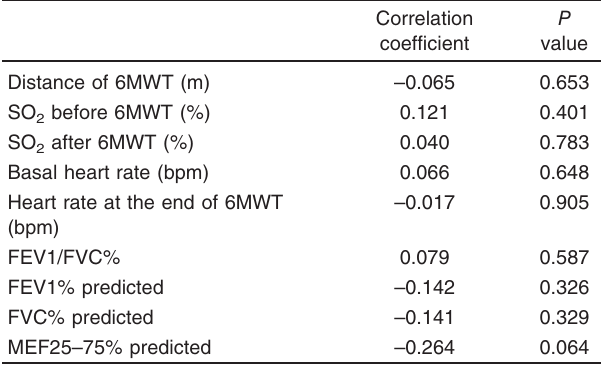
Table 3 Correlation between serum level of interleukin 6 and the 6-min walk test and the spirometric parameters in the chronic obstructive pulmonary disease group Correlation